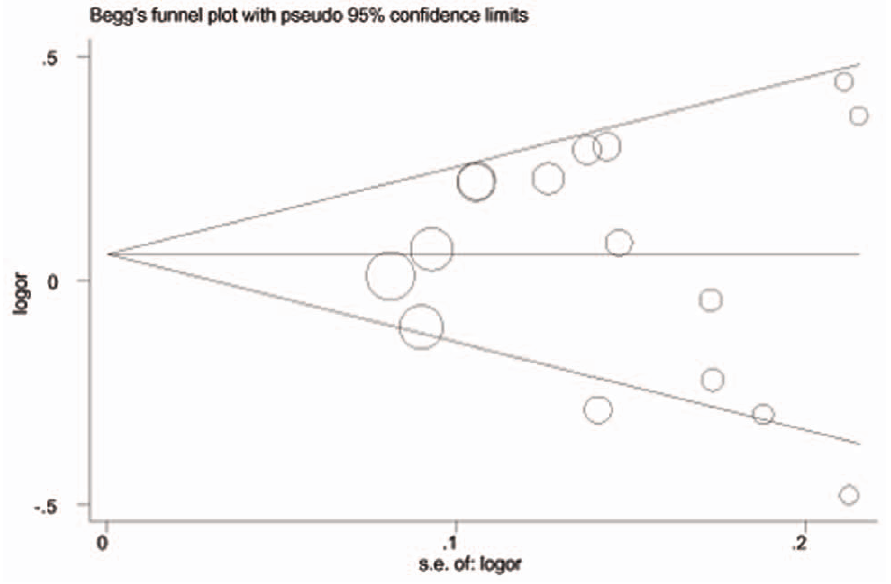
Figure 3. Begg’s funnel plot for publication bias test (CC versus TC/TT). Each point represents a separate study for the indicated association. Log[or], natural logarithm of OR. Horizontal line, mean effect size.